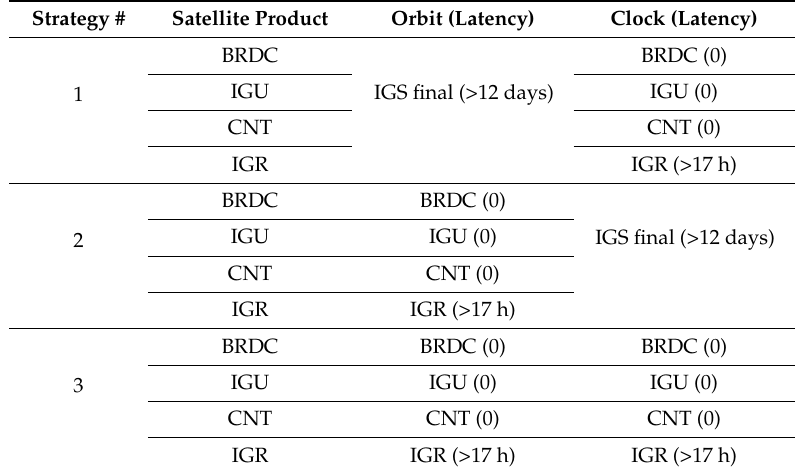
Table 4. Real-time satellite orbit and clock combination in three processing